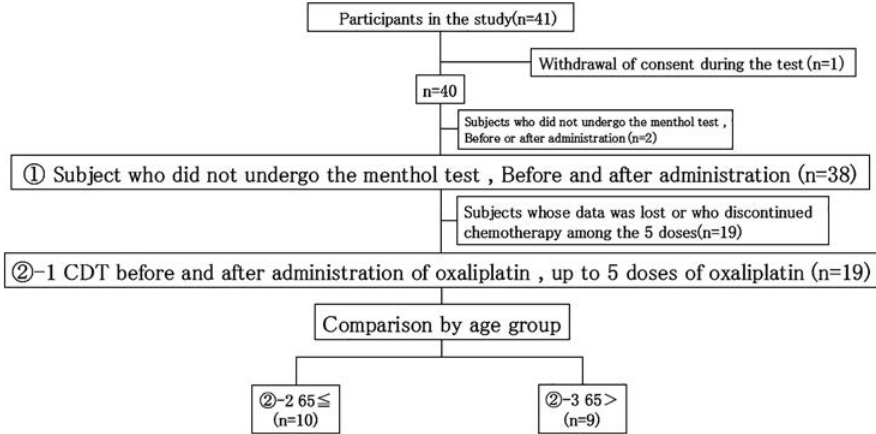
Figure 3 Cold sensation detection threshold (CDT) before and after the administration of oxaliplatin, with up to five doses of oxaliplatin (